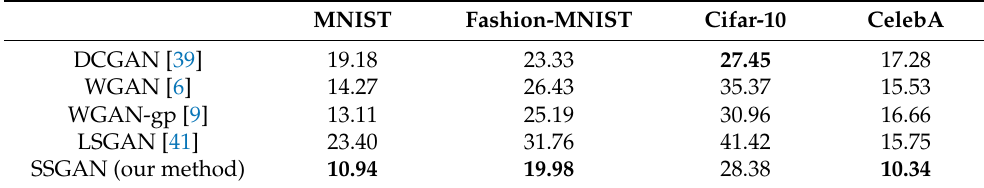
Table 2. FID of SSGAN and other methods. The results show that the proposed SSGAN outperforms previous